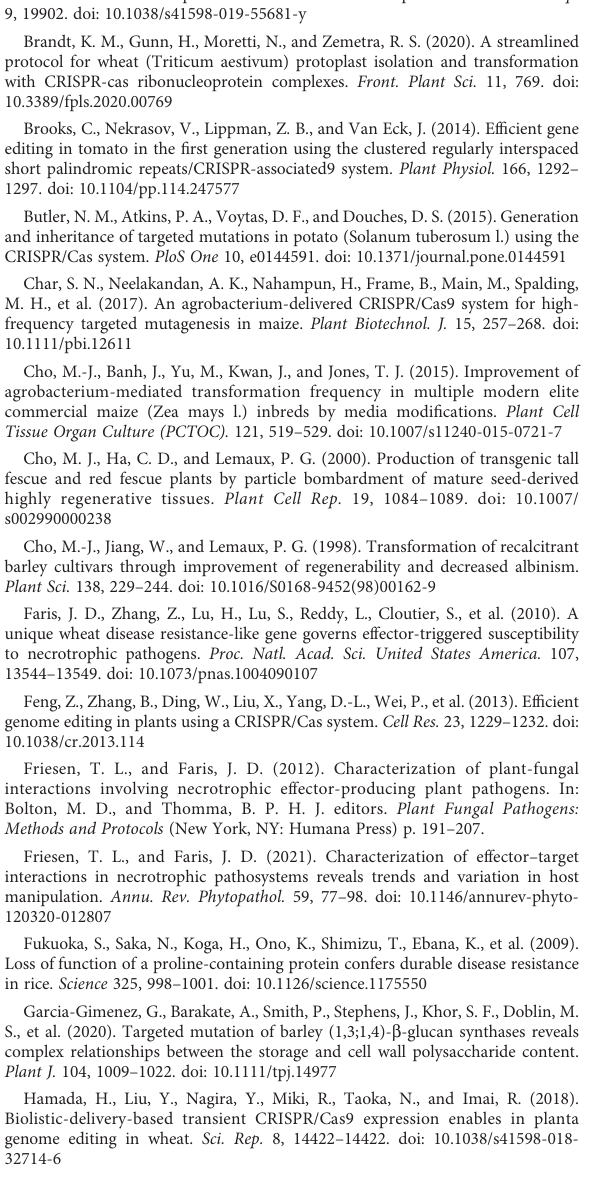
SUPPLEMENTARY TABLE 2 Primers used to amplify the target region for amplicon next generation sequencing. Nucleotides shown in capital letters are the 5 ′ -stub compatible with Illumina NGS library preparation. SUPPLEMENTARY TABLE 3 Genotypes of all edited M 0 plants obtained. + indicates the number of base pairs inserted, - indicates the number of base pairs deleted. SUPPLEMENTARY FIGURE 1 Protoplast viability curve. N=3. Error bars indicate SEM.